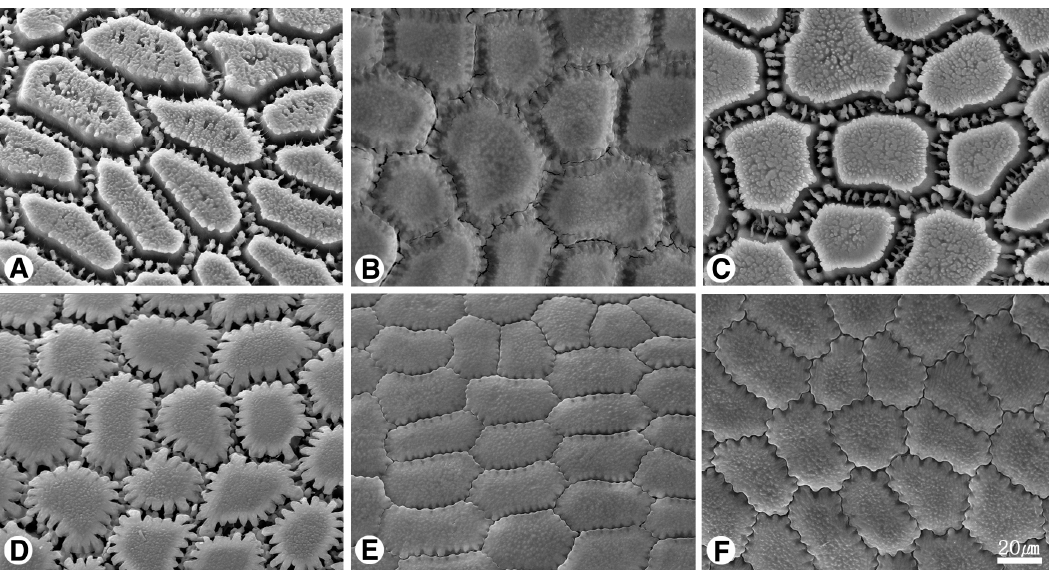
Figure 8. Scanning electron micrographs of seed testa in Allium . A – F subg. Rhizirideum : A A. bidentatum ; B A. polyrhizum (sect. Caespitosoprason ); C A. austrosibiricum (sect. Rhizirideum ); D A.